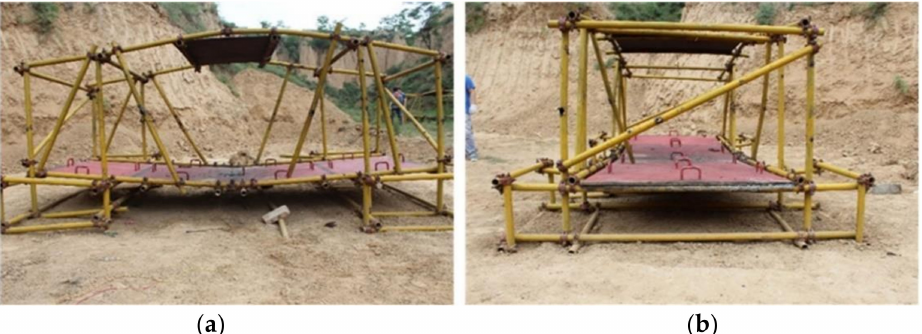
Figure 7. Damage to the composite steel structure after the explosion with a certain explosion height. ( a ) Front view; ( b ) Side